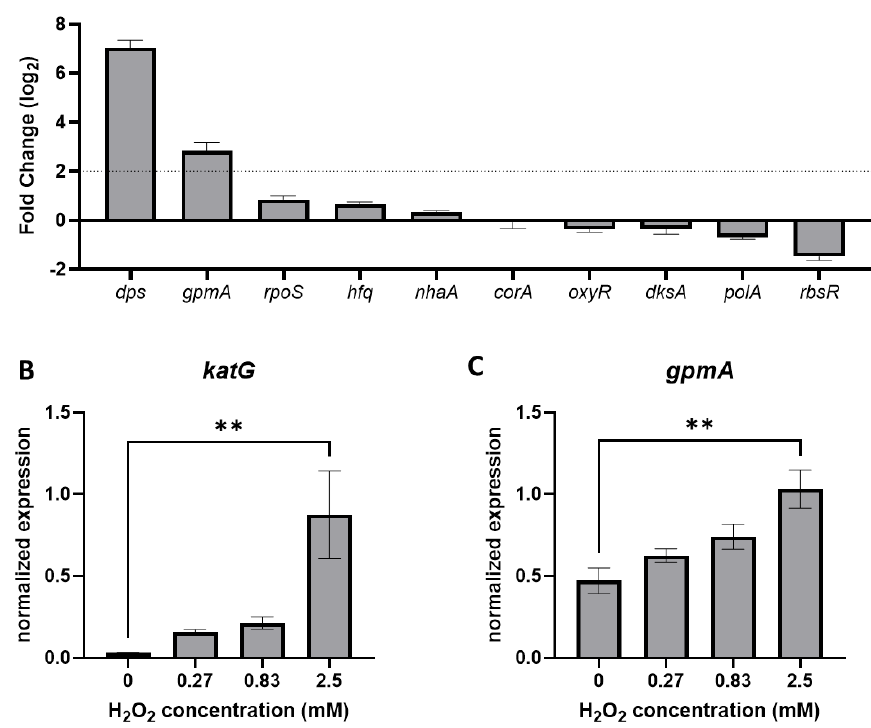
Figure 4. gpmA expression is upregulated following exposure to H 2 O 2 . ( A ) Differential expression of the 10 genes identified by TraDIS 10 min after exposition to 2.5 mM H 2 O 2 compared to no treatment (mean +/ − SD, N = 4). Data originated from previously performed RNA-seq (deposited on ENA with the accession number: PRJEB51098) [10]. ( B , C ) Levels of expression of katG and gpmA, respectively, in the strain MG1655 under increasing concentration of H 2 O 2 , assessed by qRT-PCR, ** corresponds to p < 0.01. (SEM +/ − SD, N = 3).